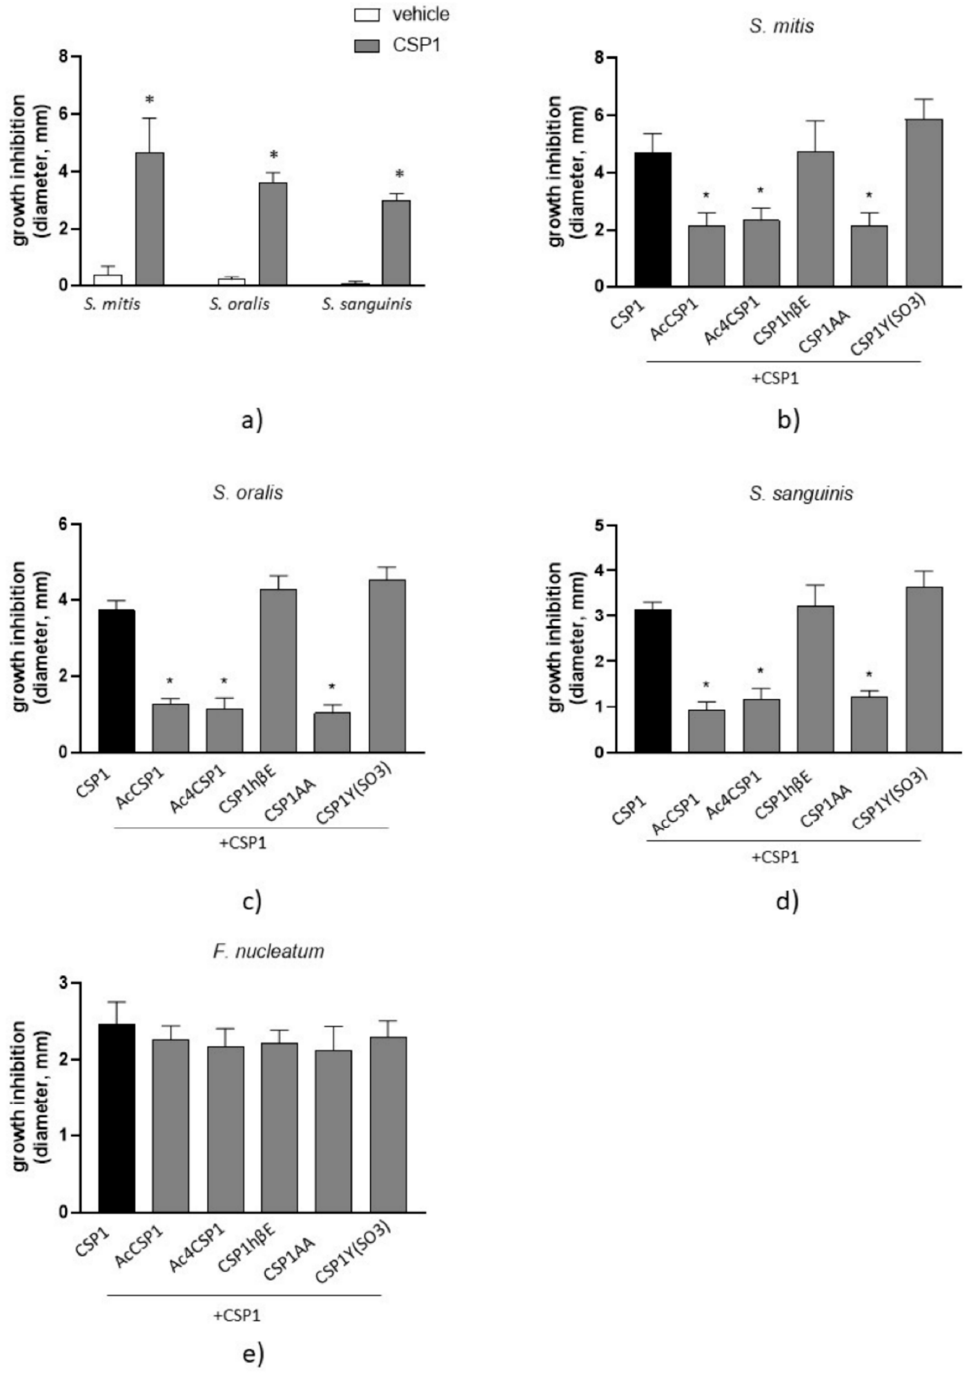
Figure 3. Bactericidal activity of synthesized peptides. ( a ) Cultures of S. mutans were incubated with the vehicle or CSP1 (20 μ M) and spotted on 0.7% agar media on the surface of agar plates previously inoculated with S. mitis , S. oralis , or S. sanguinis . Plates were incubated under microaerophilic conditions at 37 °C for 16 h. Cultures of S. mutans were incubated with CSP1 and analogs (20 μ M) and plated as described above. Cultures were spotted on agar plates inoculated with S. mitis ( b ), S. oralis ( c ), or S. sanguinis ( d ). Plates were incubated under microaerophilic conditions at 37 °C for 16 h. S. mutans cultures were spotted on agar plates inoculated with F. nucleatum and incubated under